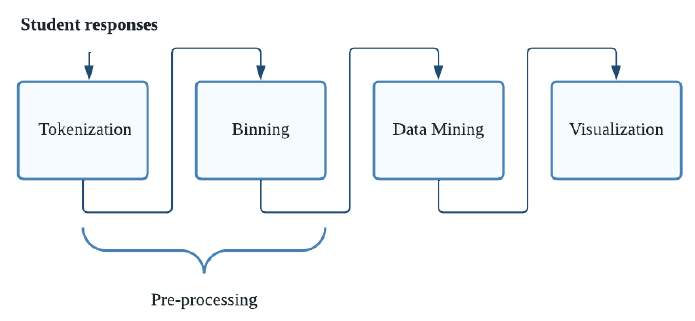
Figure 3. Process for obtaining a word cloud.